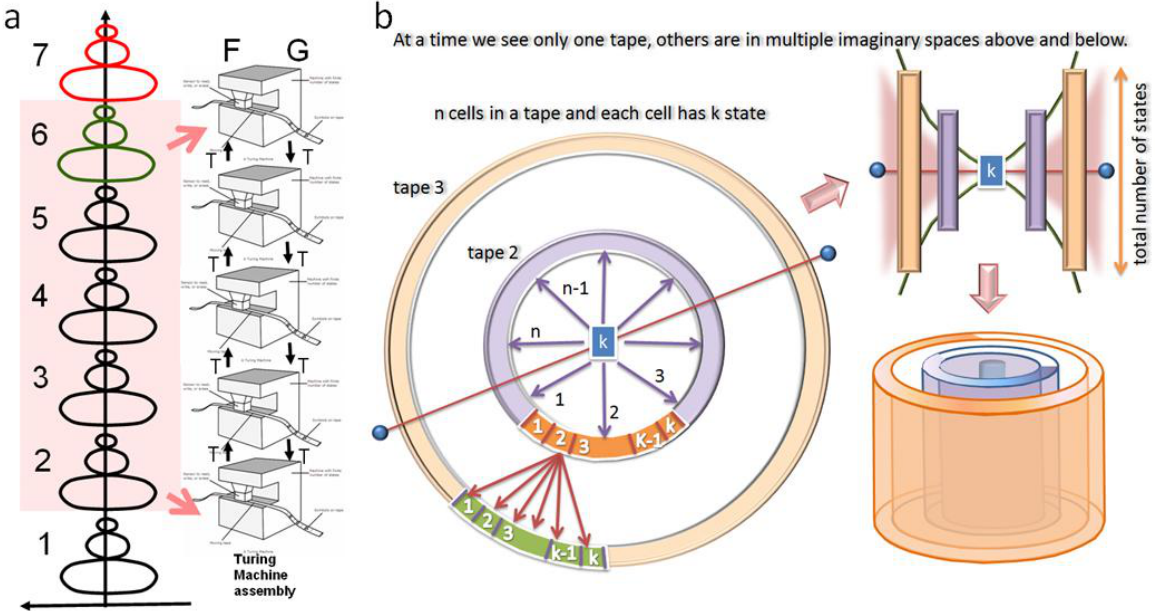
Figure 10. ( a ) Resonance chain represented by a network of Turing machines working independently for the imaginary and real numbers; ( b ) Godel incompleteness based engine for our computer that should replace the Turing